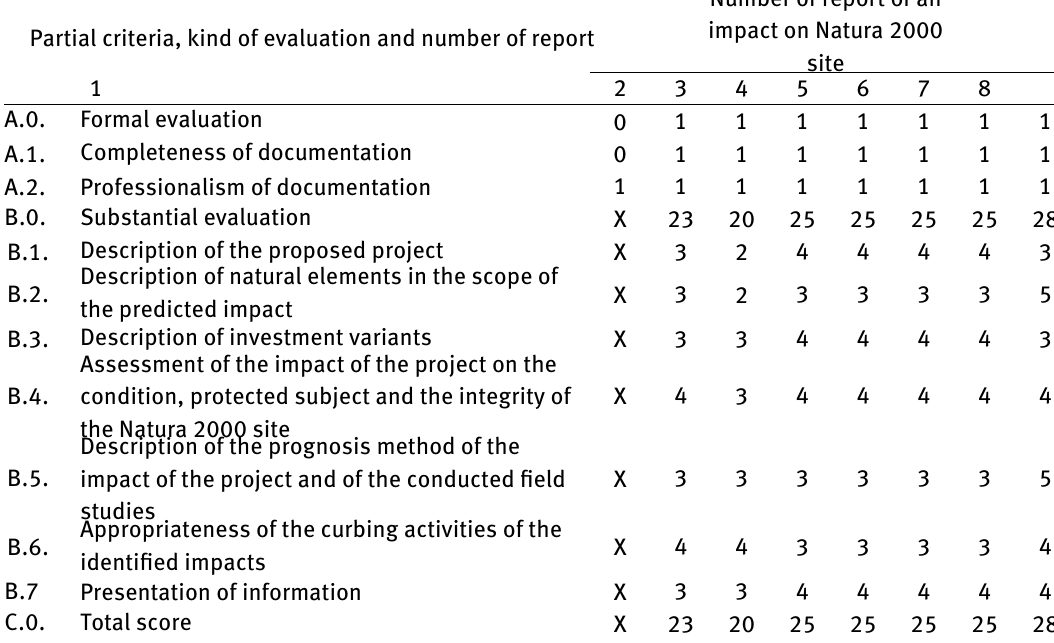
Table 2: Evaluation of the chosen reports with the point scalarisation method.